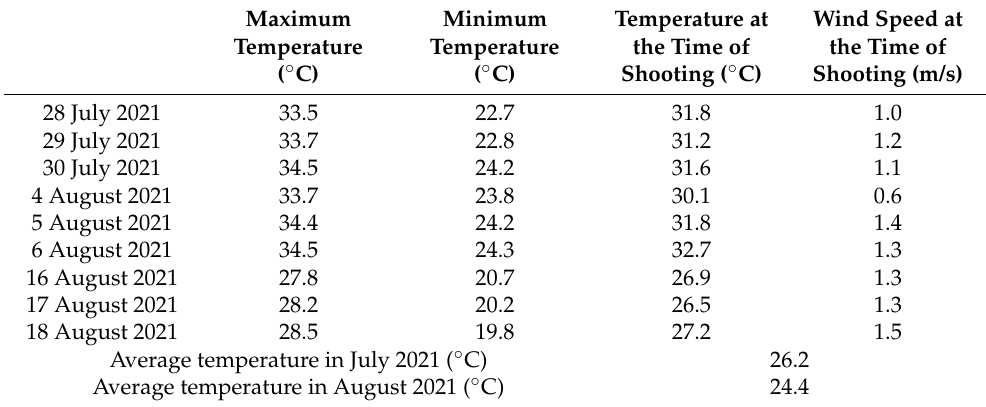
Table 2. Weather information on the day the image was taken, and the average monthly temperatures were recorded. Maximum Temperature ( ◦ C) Shooting ( ◦